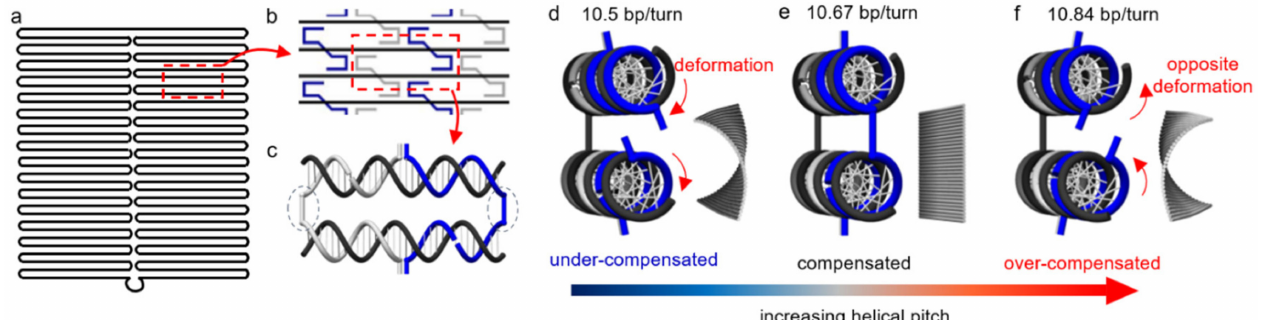
Figure 1. Schematics of the conformational change in a DNA origami. ( a ) Layout of scaffold pattern in a rectangular origami tile. ( b ) A section of the origami tile indicating the periodic arrangement of the staples (blue and gray) against the scaffold (black). ( c ) The repeating segment indicated as a red dashed box in ( b ). The staples (blue and gray) pair with the scaffold (black), forming double helices connected by crossovers (indicated by blue dotted circles). There are 32 bp between the adjacent crossovers for three turns, corresponding to 10.67 bp/turn. ( d – f ) Side views of the periodic arrangement in (c) along with corresponding origami conformations from finite element simulations using CanDo on the right. ( d ) The DNA duplexes experience significant torsional deformation under natural conditions (10.5 bp/turn) in order to maintain crossover connections. The helical mismatch results in a right-handed twist over the entire origami tile. If the mismatch is compensated, crossovers will form without distortion. As such, the tile will be perfectly flat ( e ). Over-compensating the mismatch (e.g., 10.84 bp/turn) will lead to a left-handed twist in the origami tile ( f ). (Contents in this figure were previously published. Adapted with permission from [42]. Copyright (2016) American Chemical Society. Further permissions related to the material excerpted should be directed to the